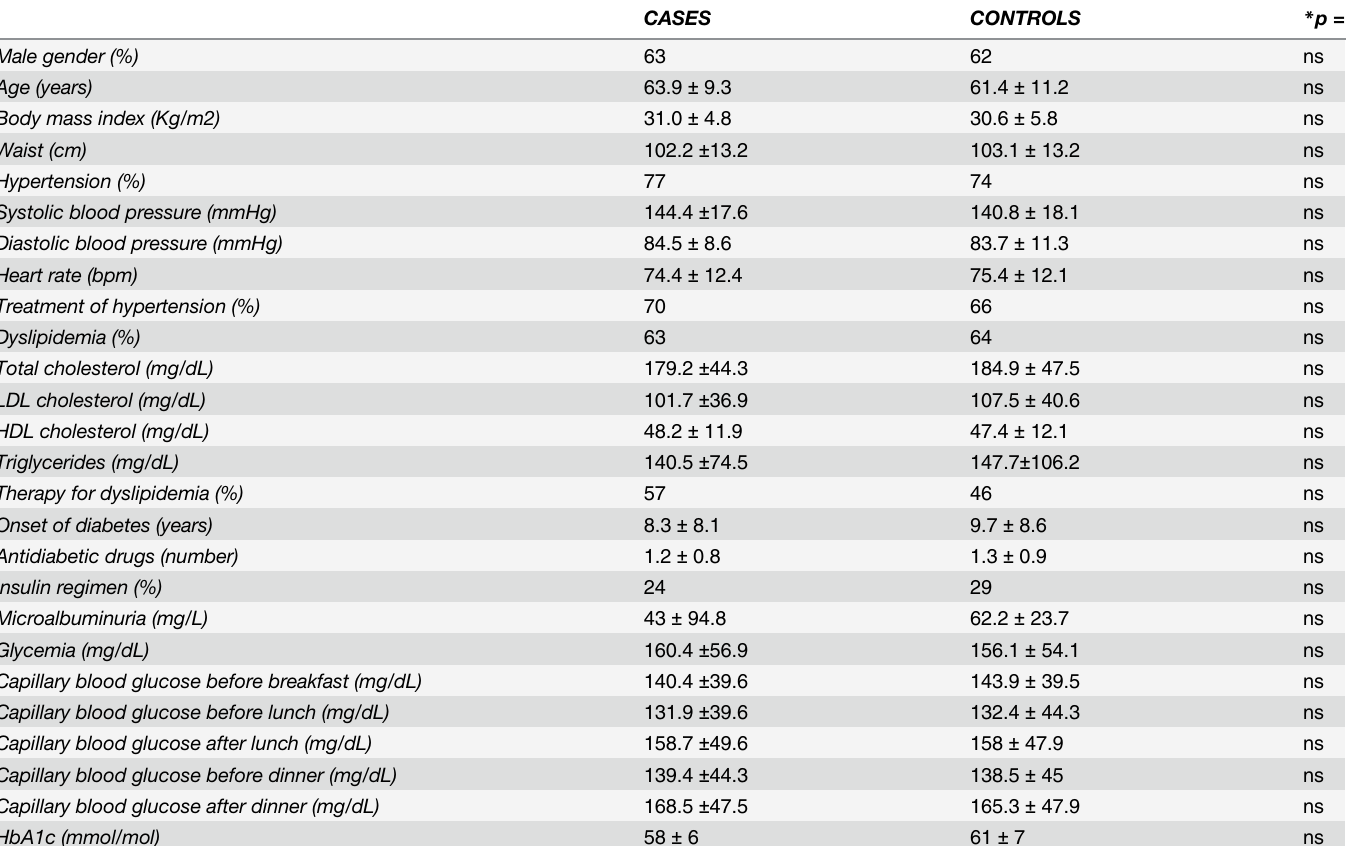
Table 1. Baseline features of the two study